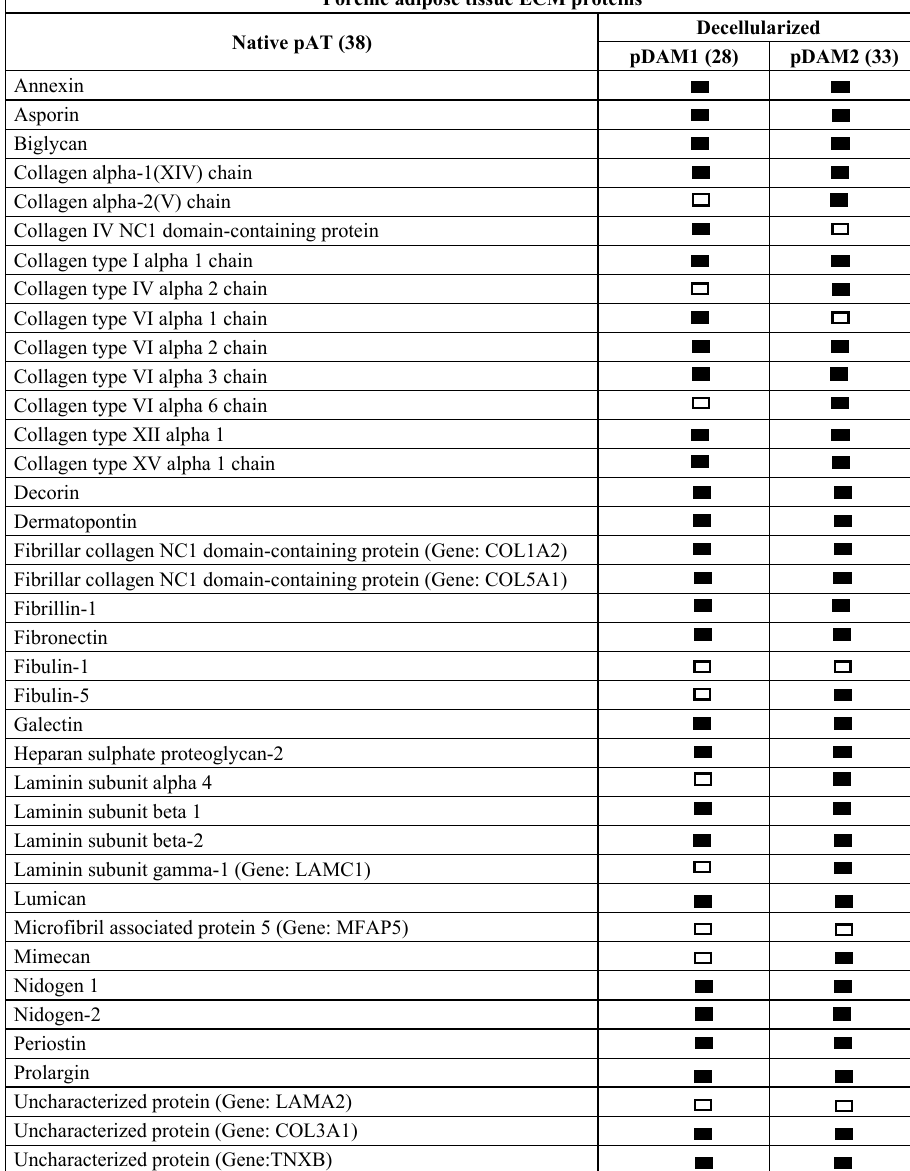
Figure 2. Porcine ECM protein composition before (native) and after AT decellularization by method 1 (pDAM1) and method 2 (pDAM2).